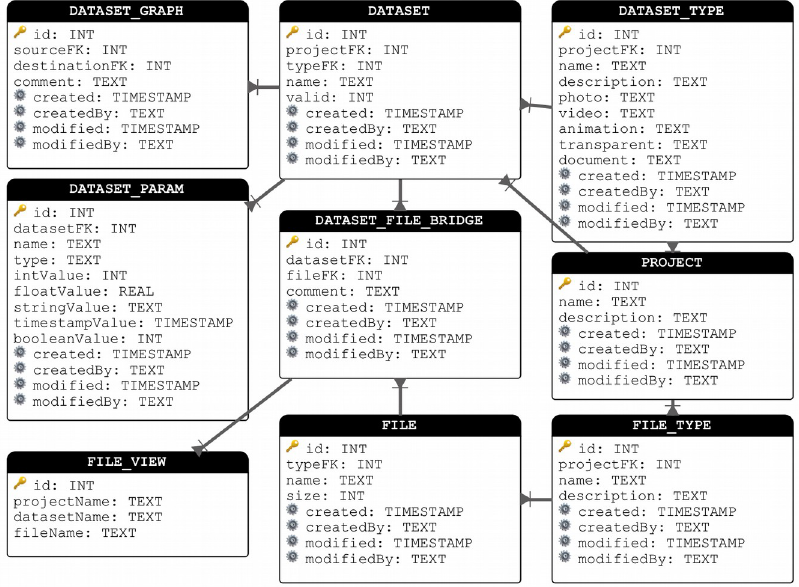
Figure 1. Sample database structure. In this schema, each table contains a unique auto-incremented identifier called “id”. The “PROJECT” table contains projects information. This table doesn’t have any foreign key (relation). The “DATASET” table contains entities representing a set of data. “DATASET” is linked to “PROJECT” with the foreign key constraint ( DATASET.PROJECTFK